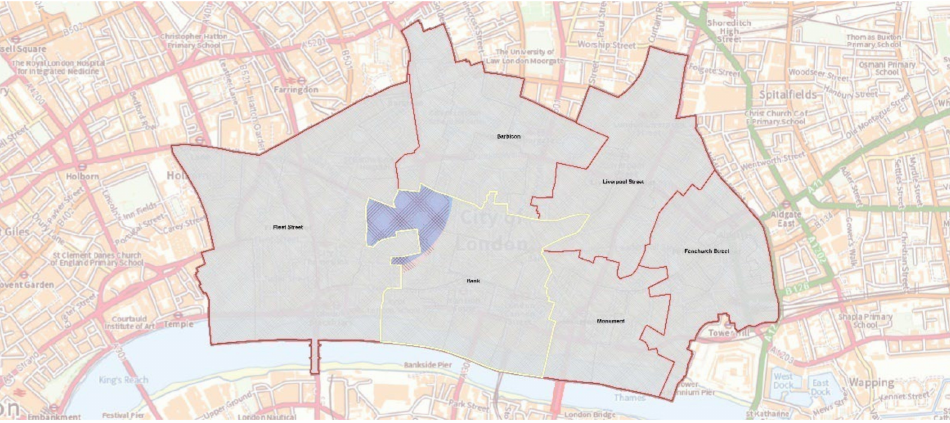
Figure 6. Drug crime hot spots in the Bank cluster for the years 2019 (marked in blue) and 2020 (marked in red).